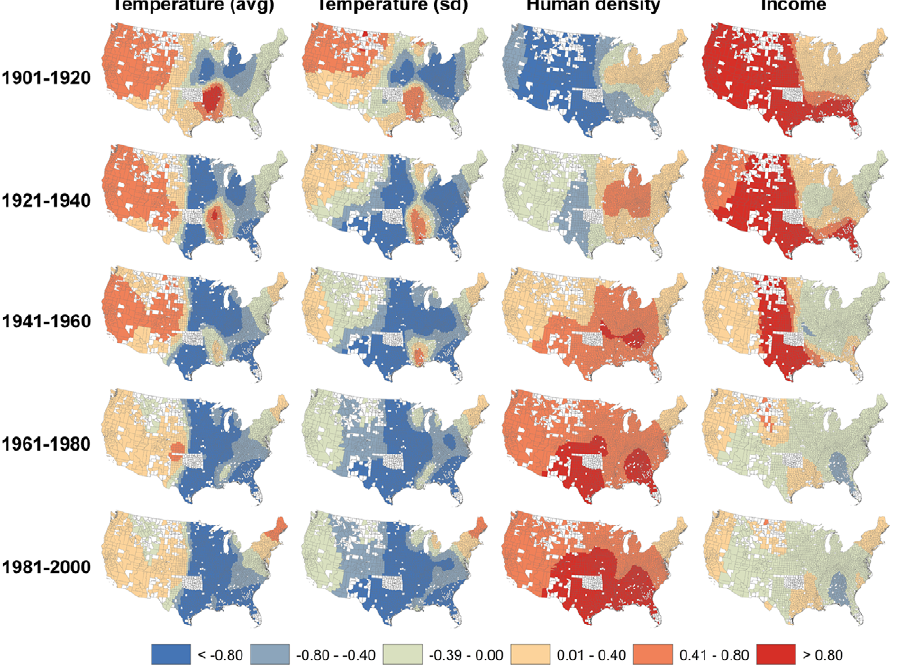
Figure 6. Standardized regression coefficients (Std b ) of the four most important predictors of demographic growth rates. Counties shown in white were not included in the analyses because they did not have consistent census data or changed their geographical boundaries during the 20 th century. See Fig. S7 for the Std b of the four other variables used in this analysis.